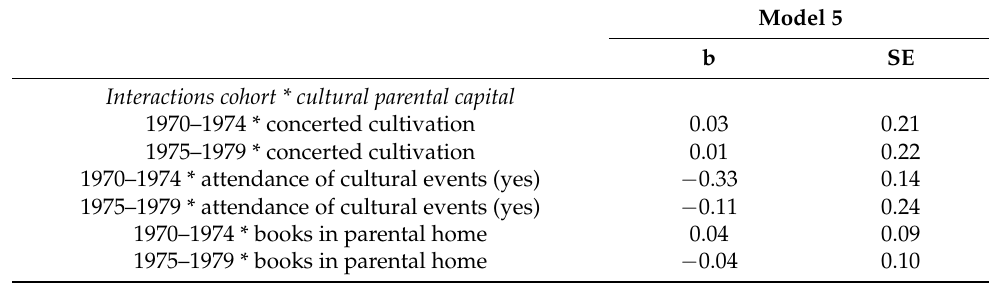
Table A2. Respondent’s educational attainment conditional to cohort and parental cultural